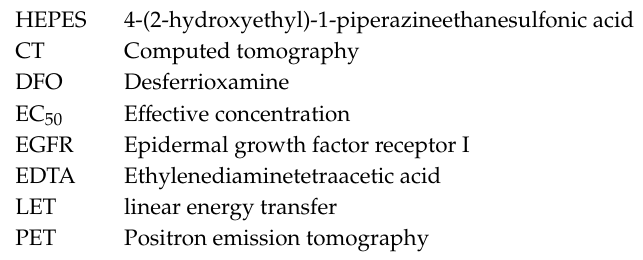
Figure S1: Representative size exclusion (SEC) HPLC profile of 89Zr-nimotuzumab-SpyTag- ∆ N-SpyCatcher. UV channels at 220 and 280 nm show “cold” antibody and radiometric channel shows the radiolabeled antibody with a purity > 95%, Figure S2: Stability of 89Zr-nimotuzumab-SpyTag- ∆ N-SpyCatcher in saline and human plasma at 37 ◦ C for di ff erent time points, Figure S3: Representative size exclusion (SEC) HPLC profile of 225Ac-nimotuzumab-SpyTag- ∆ N-SpyCatcher. UV channels at 220 and 280 nm show “cold” antibody and radiometric channel shows the radiolabeled antibody with a purity > 95%, Figure S4: Stability of 225Ac-nimotuzumab-SpyTag- ∆ N-SpyCatcher in saline and human plasma at 37 ◦ C at di ff erent times post incubation. Average body weight of mice during treatment for the di ff erent